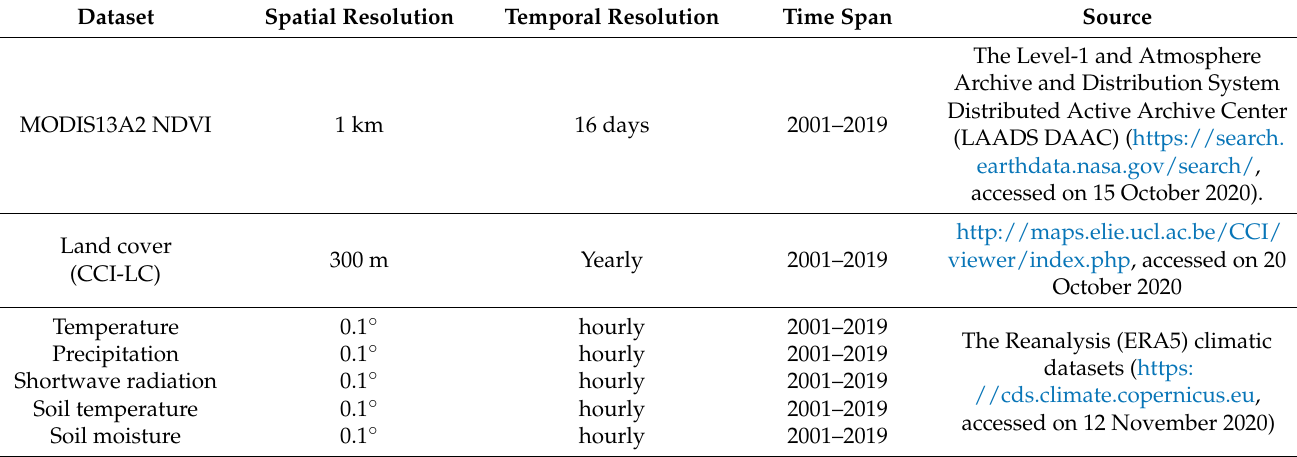
Table 1. Datasets and sources in the study